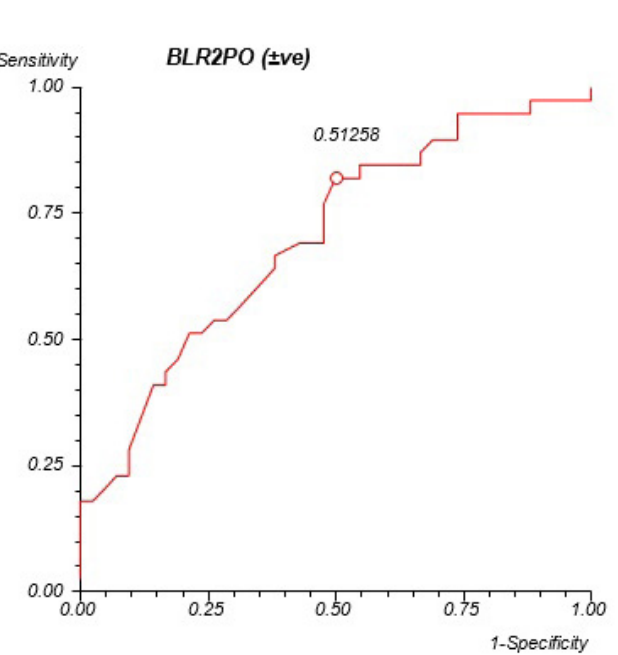
Fig. 2 - ROC curve for BLR2PO. Area under the ROC curve=0.708; P=0.003; Sensitivity=82.05%; Specificity=51.16%.